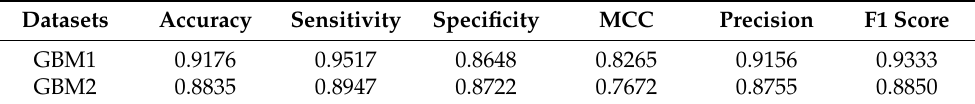
Table 1. Predictive performances of the GBM1 and GBM2 datasets. All predictions were optimized using the MCC as the fitness function.